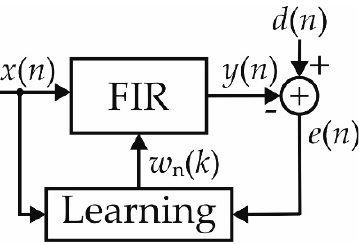
Figure 1. Simplified scheme of the Least Mean Square algorithm.